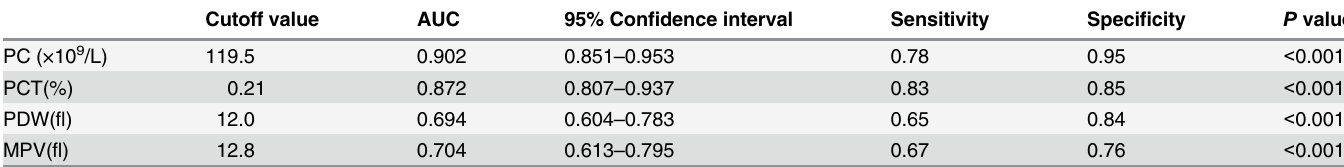
Table 2. ROC analysis for the prediction of IFD by platelet parameters using the cutoffs with the maximal sum of sensitivity and specificity. Cutoff